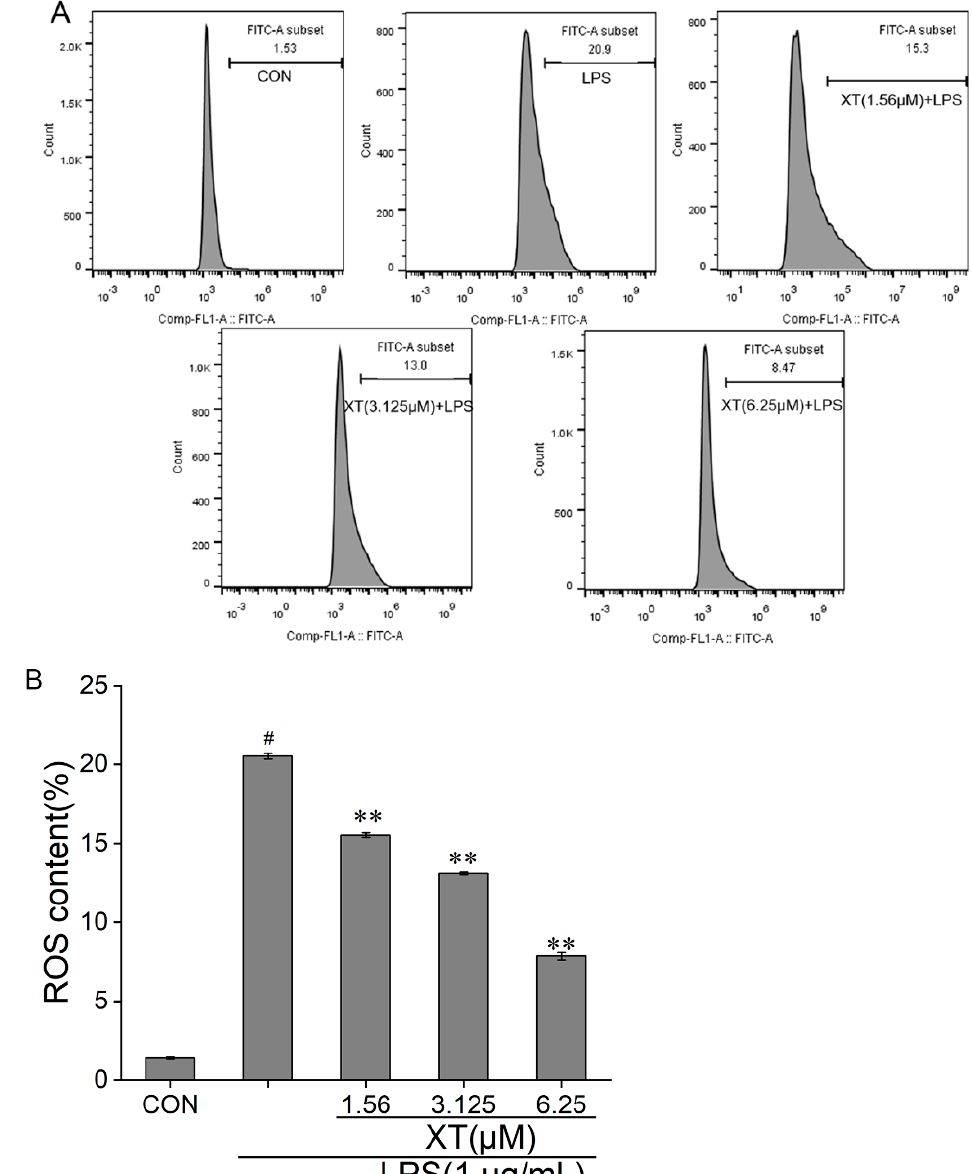
Figure 4. Effects of xanthatin on LPS − induced mRNA levels of iNOS ( A ), COX − 2 ( B ), TNF −α ( C ), IL − 1 β ( D ) and IL − 6 ( E ) in RAW 264.7 cells. When cells were pre − treated with xanthatin and activated by LPS, the mRNA levels of iNOS, COX − 2, TNF −α , IL − 1 β and IL − 6 was detected by qPCR. These results for the related mRNA expression levels were normalized with β− actin. Data is shown as means ± SDs (n = 3). #: significantly different compared to the control (CON) group, *: p < 0.05, **: p < 0.01, as compared to the LPS − induced group.